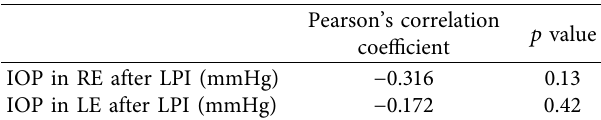
Table 5: Correlation between age and IOP reduction after